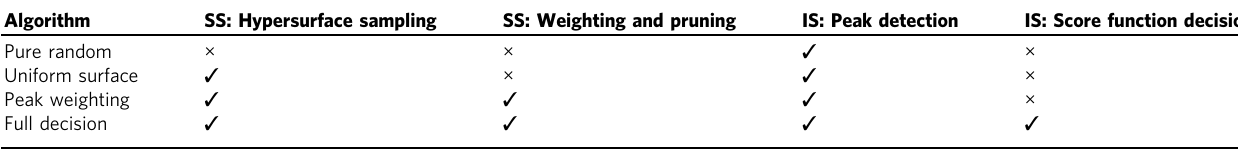
Modules in the sampling stage (SS) and the investigation stage (IS) are indicated with a tick if included and with a cross if